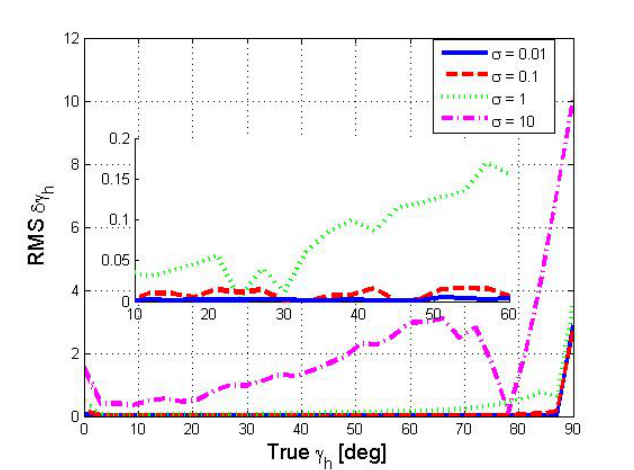
Figure 7. RMS of δγ h as a function of γ h . Curves represent different accelerometer variance values σ in (cid:112) ( units of µ g/ Hr ) .